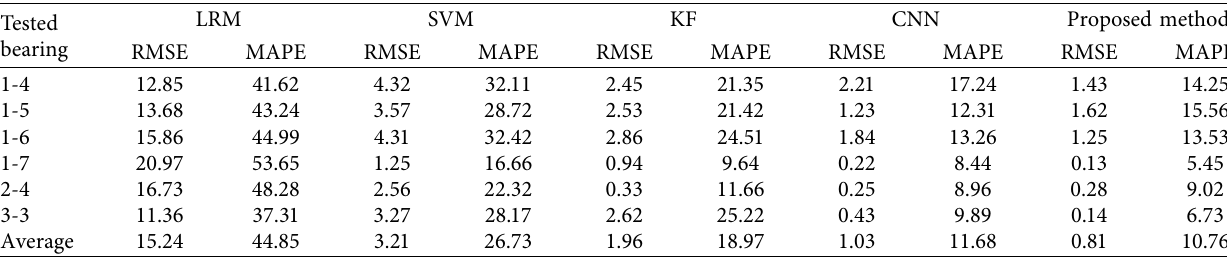
Table 4: Numerical prognostic performance comparisons of various approaches. Tested